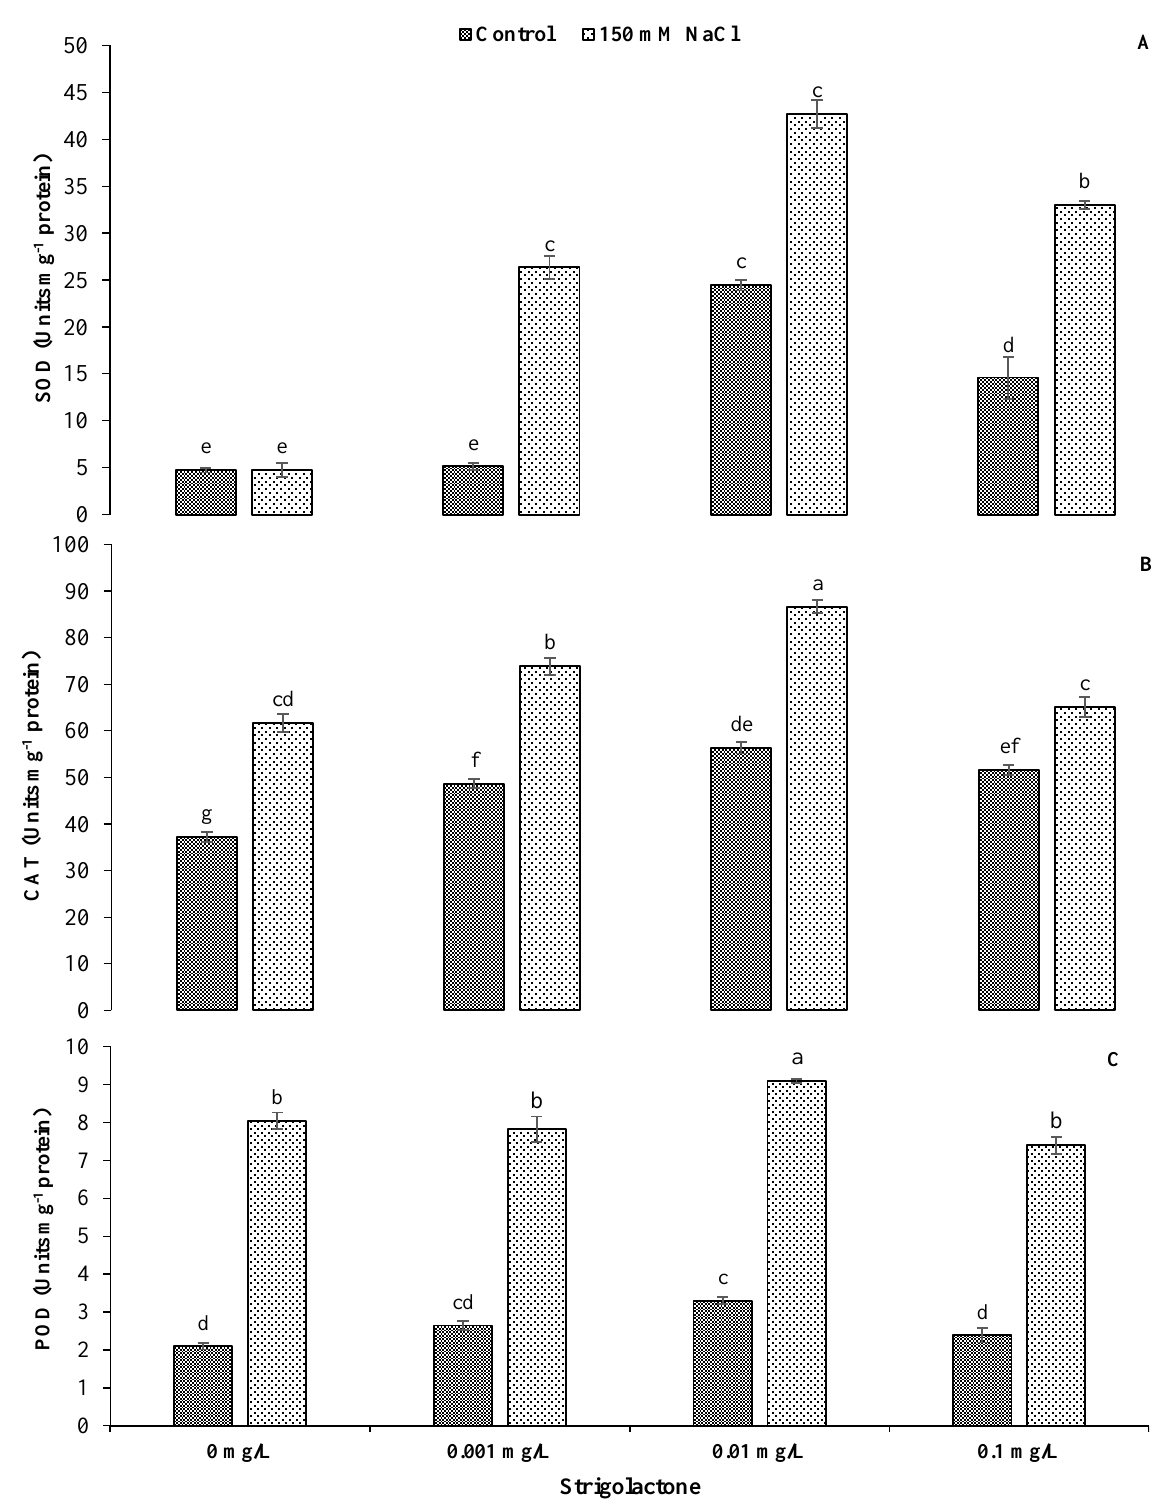
Figure 5. Impact of GR24 on antioxidant enzymatic activities, i.e., superoxide dismutase ( A ), catalase ( B ) and peroxide ( C ), in ornamental sunflower under control and salt stress conditions. Each vertical bar shows the mean of three replicates. Different letters indicate significant differences among treatments at p ≤ 0.01 according to least significant difference test.